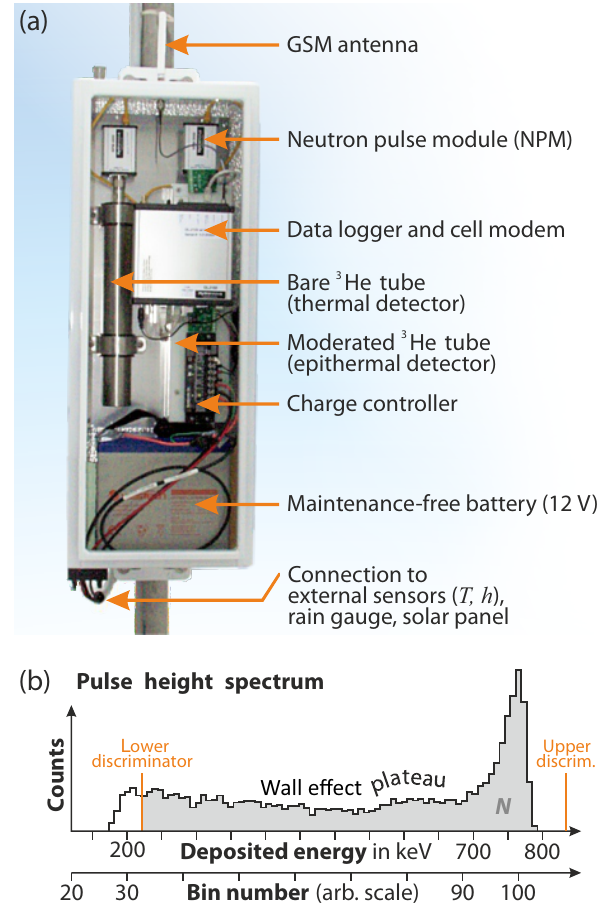
Figure 1. (a) Inside view of the cosmic-ray neutron sensor (CRNS) of type “CRS1000”. The moderated tube (surrounded by a white polyethylene block) mainly detects epithermal neutrons and is thus sensitive to water in the environment. (b) A typical, measured pulse height spectrum (PHS) shows the deposited energy in the gas tube. Upper and lower discriminators (orange) delimit the region (grey) in which events are interpreted as neutron counts N . Illustrated dis- criminator positions are examples. The internal representation of released energy as bin numbers is a specific feature of the